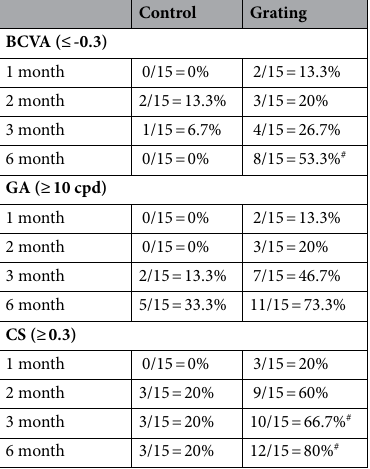
Table 2. Participants have gained better BCVA, GA, and CS of trained eye at the 1st, 2nd, 3rd, and 6th months after the training in the control and Grating groups. # p < 0.05 vs. the control group by χ 2